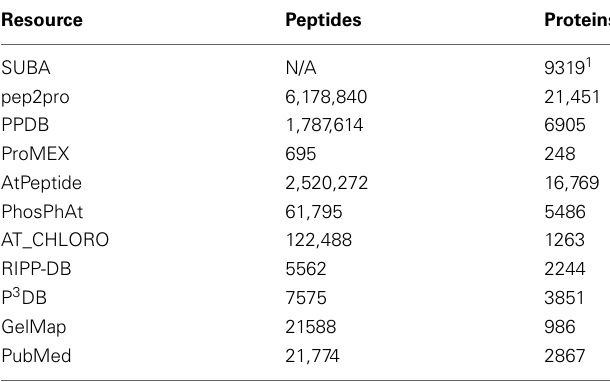
Table 1 | Summary of proteomic derived information (August 2013) currently aggregated and displayed by the MASCP